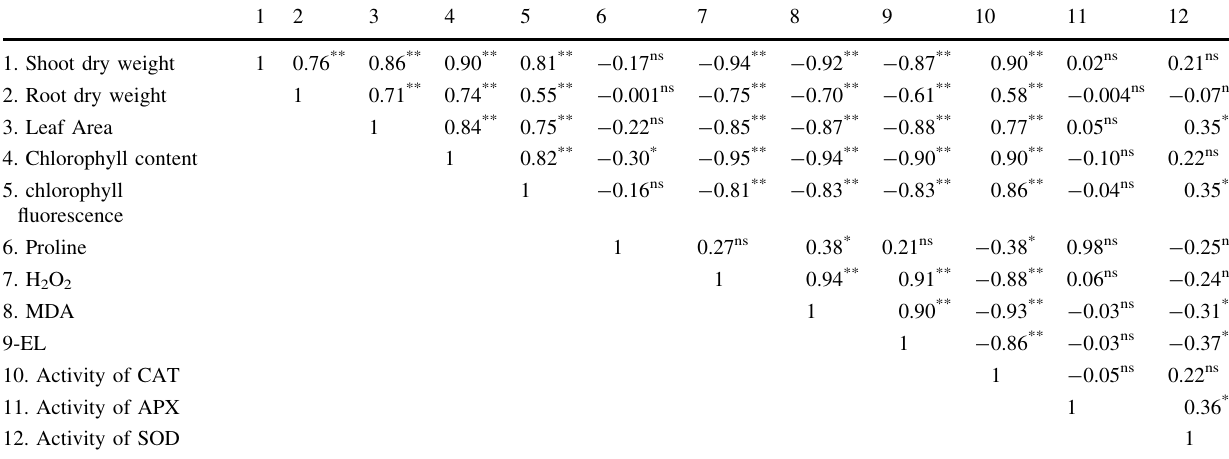
Table 7 Correlation between measured traits of pomegranate